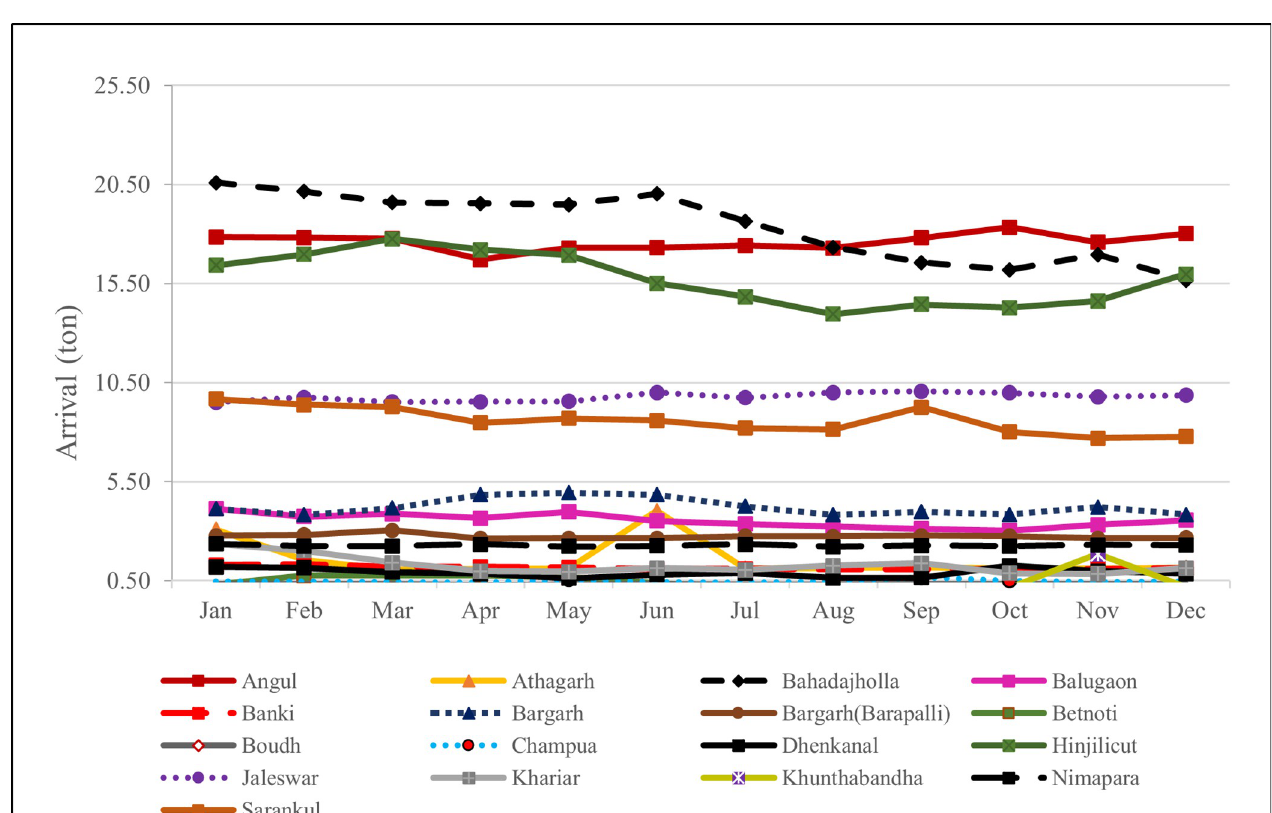
Fig 6. Average monthly arrival of brinjal in important markets of Odisha.